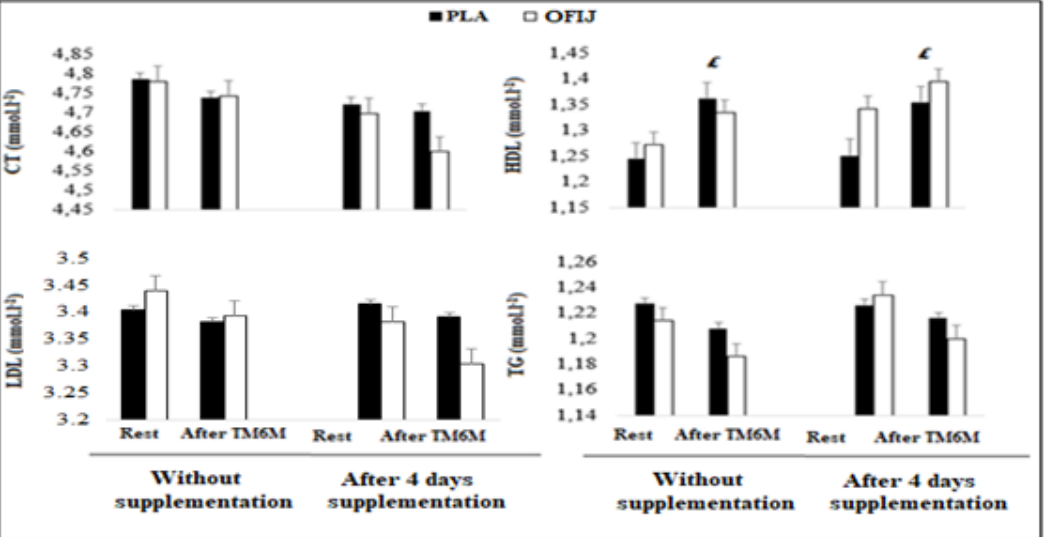
Figure 4. Lipid-profile parameters (mean ± SD; n = 20) recorded before and after the 6MWT during without and with supplementation of PLA and OFIJ. £: significant difference compared to before the 6MWT ( p < 0.05).